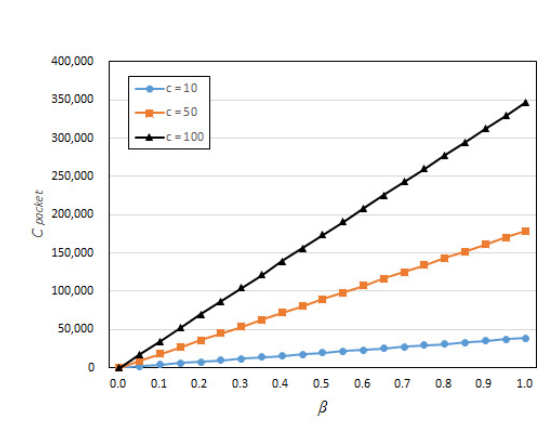
Figure 10. Signaling overhead ( l